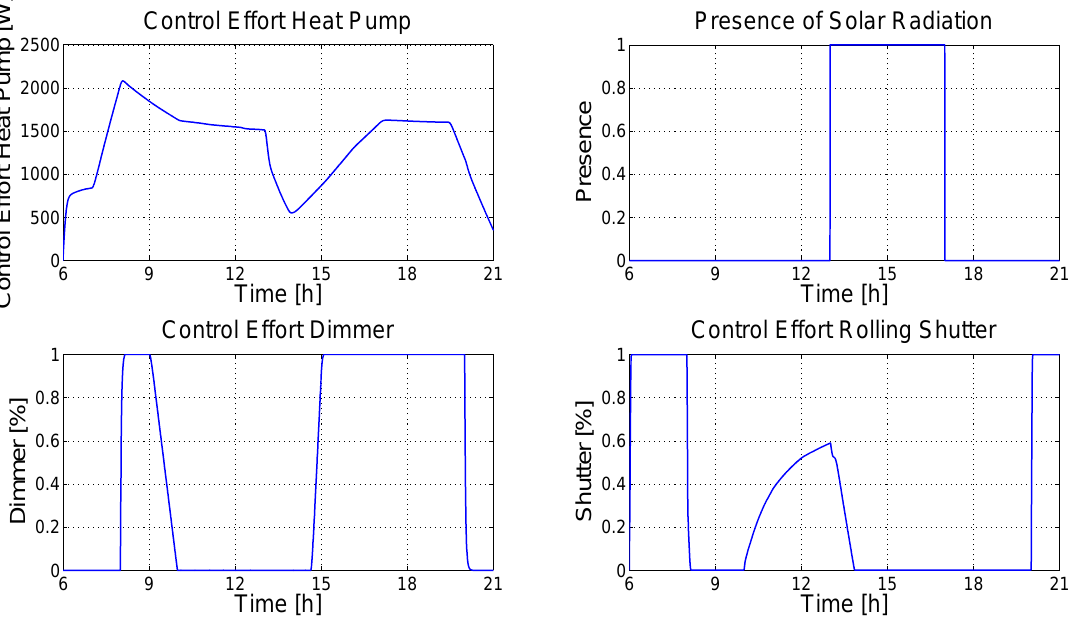
Figure 35. Control results (second scenario, modified control system, Energy Saving policy): MVs (heat pump, dimmer, and rolling shutters) and DV (presence of solar radiation). The third scenario is represented in Figures 36–41: it refers to the summer season; the modified control system cools the room in the Comfort policy (Figures 36–38) and in the Energy Saving policy (Figures 39–41). Figures 36, 37, 39, and 40 report the CVs (blue lines), together with the defined setpoints (green lines), and two DVs, i.e., the outside tempera- ture (red line) and solar radiation (magenta line). MVs are depicted in Figures 38 and 41, together with the presence of solar radiation. As in the second scenario, time-varying set- points are assigned to room temperature and illuminance, considering the presence check. Similar behaviors can be observed in both the control policies on the room temperature